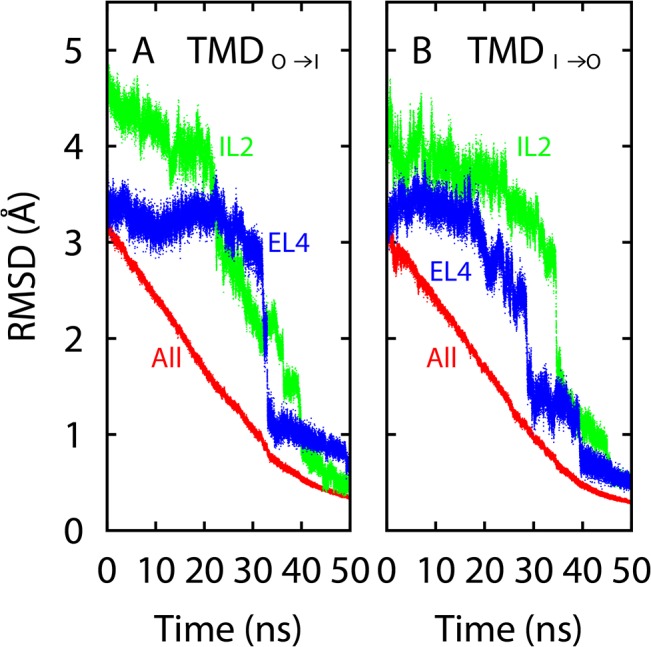
RMSDs from the two TMD simulations.For each simulation, the heavy-atom RMSDs for the EL4 and IL2 loops and the entire protein with respect to the target crystal structure are shown. (A) Results for the TMDO→I simulation. (B) Results for the TMDI→O simulation.